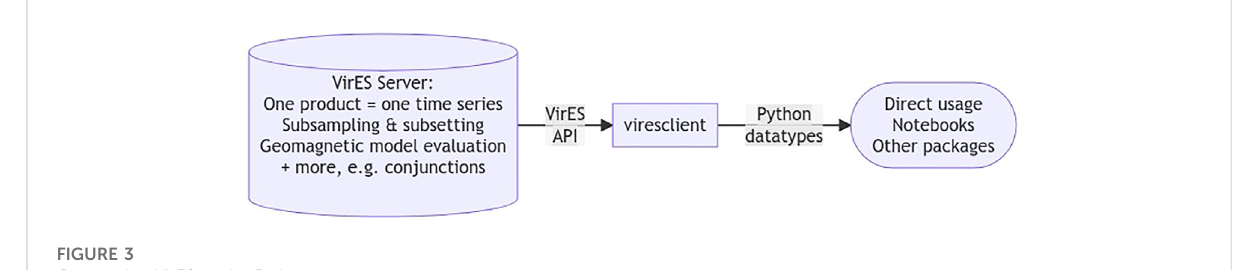
FIGURE 3 Connecting VirES to the Python ecosystem.